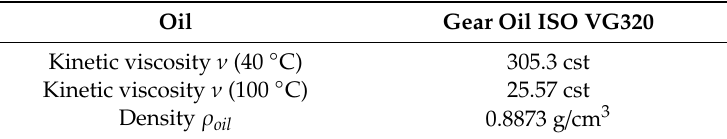
Table 2. Physical and chemical properties of lubricating oil.